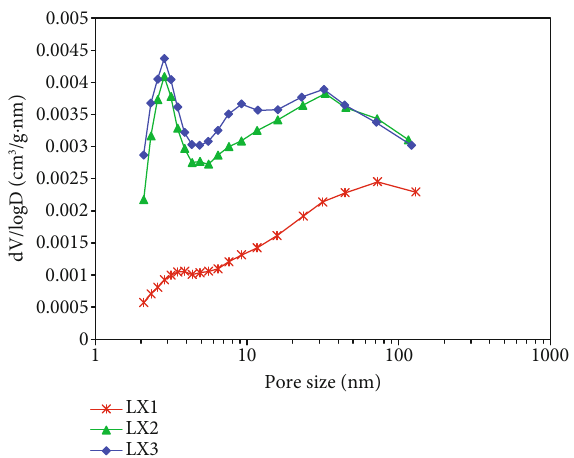
Figure 7: Pore size distribution of the three tight gas samples by nitrogen adsorption based on the BJH method.